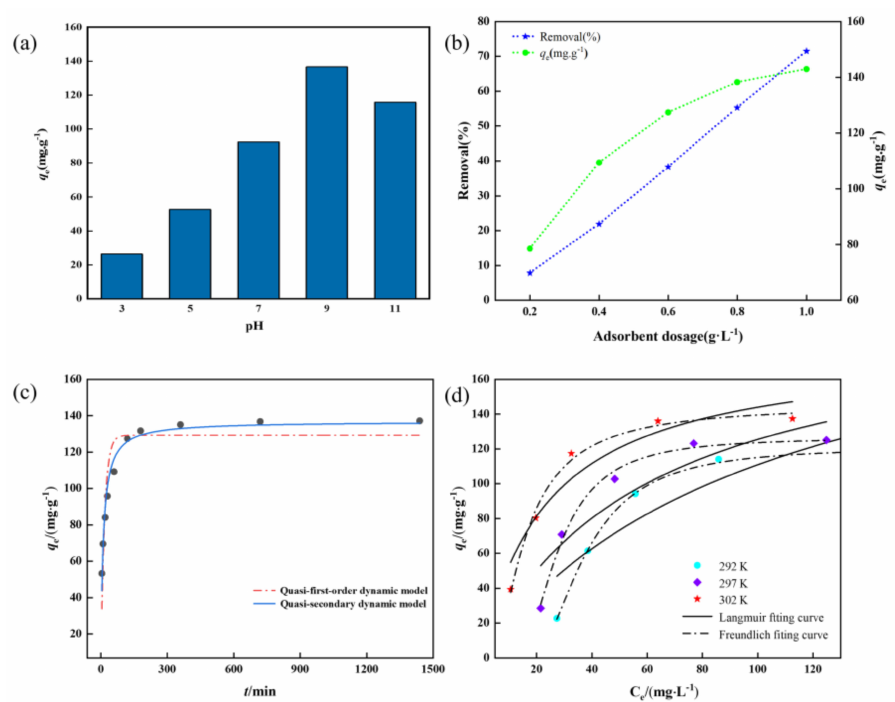
Figure 7. ( a ) Effect of initial pH value towards CV removal by GO − ATP@CS − PVA; ( b ) Effect of dosage on CV removal; ( c ) Kinetic model fitting curve of CV removal by GO − ATP@CS − PVA; ( d ) Isotherm model fitting of CV